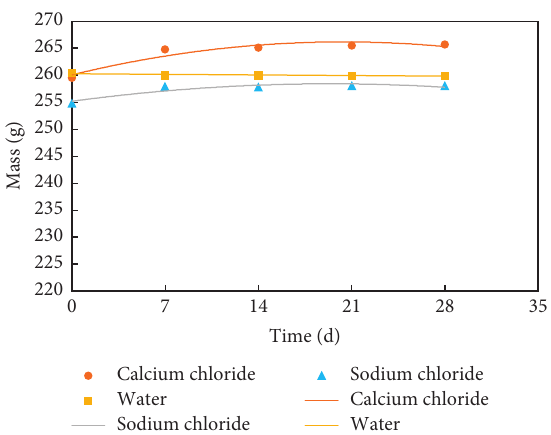
Figure 12: Mass changes of specimen with different shapes after erosion of CaCl 2 solution of HWC materials.